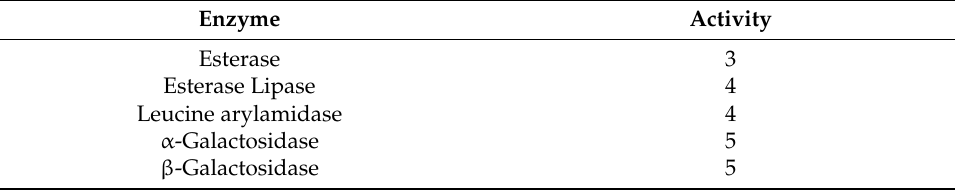
Table 3. Enzymatic activity profiles of the probiotic candidate L. fermentum MG4295.